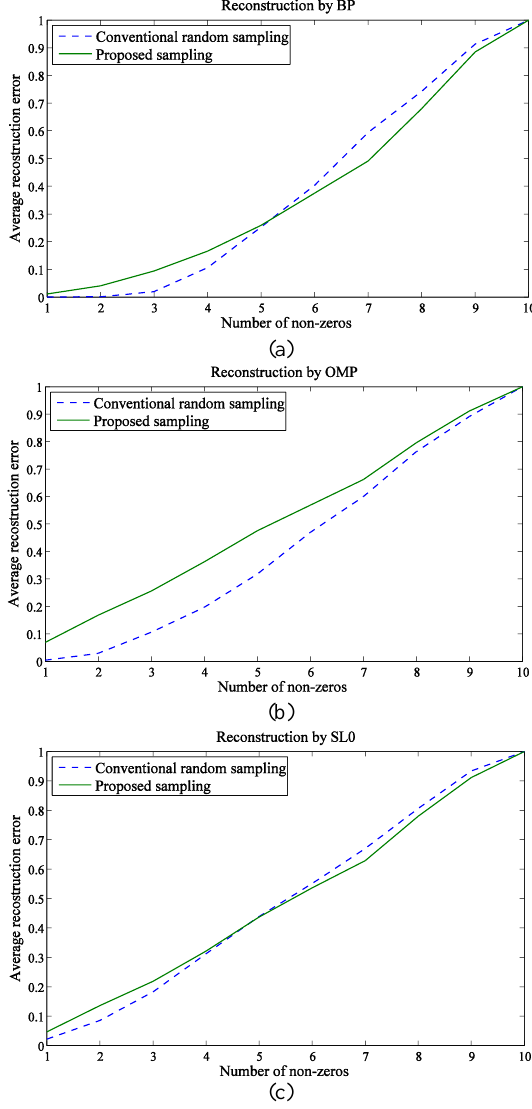
Figure 6. The reconstruction error against number of non-zeros when (a) BP, (b) OMP and (c) SL0 used as the recovery method.